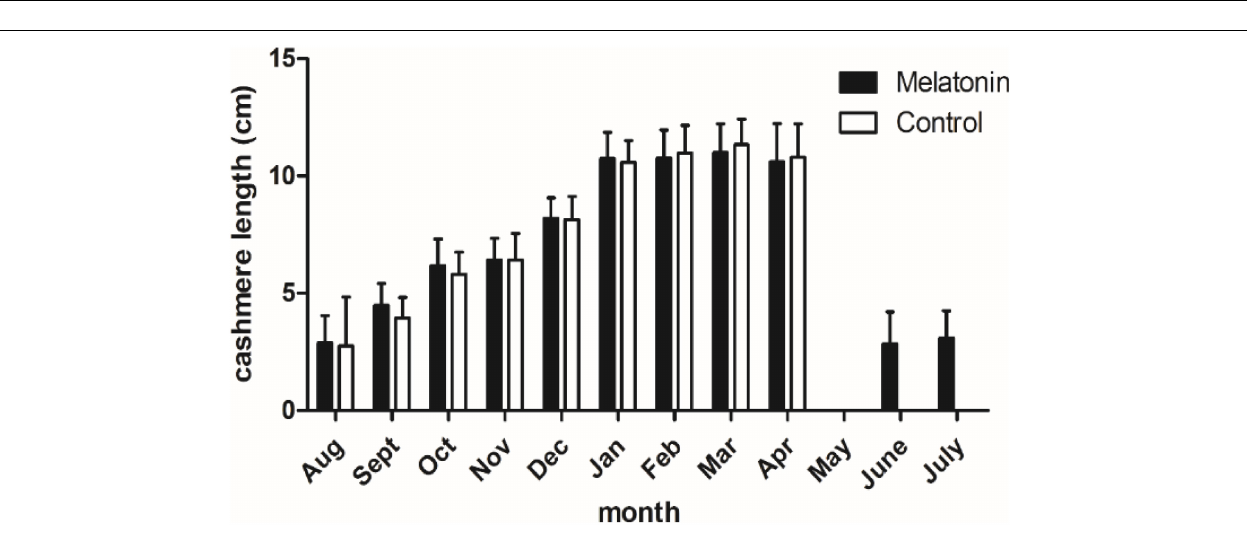
FIGURE 1 | Content of melatonin in plasma. Black histogram represents experimental group and white histogram represents control group. Control: no treatment; Melatonin: melatonin implantation. Values represent means ± SD, the punctuation ** represents P < 0.01.